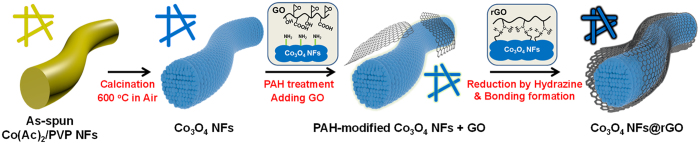
The schematic illustration of synthesis for the Co3O4 NFs and the Co3O4 NFs@rGO.